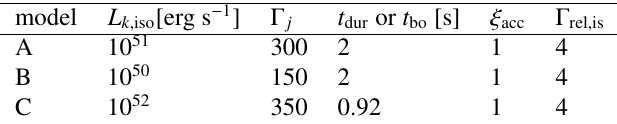
Table 4. The used parameters for the internal shock models. L k , iso is the isotropic equivalent kinetic luminosity of the jets, Γ j is the Lorentz factor of the downstream of the internal shocks, t dur or t bo is the duration of the jet launch (for models A and B) or the breakout time from the ejecta (for model C), ξ acc is the baryon loading factor, and Γ rel − is is the Lorentz factor of the internal shock. This table is adapted from [20].